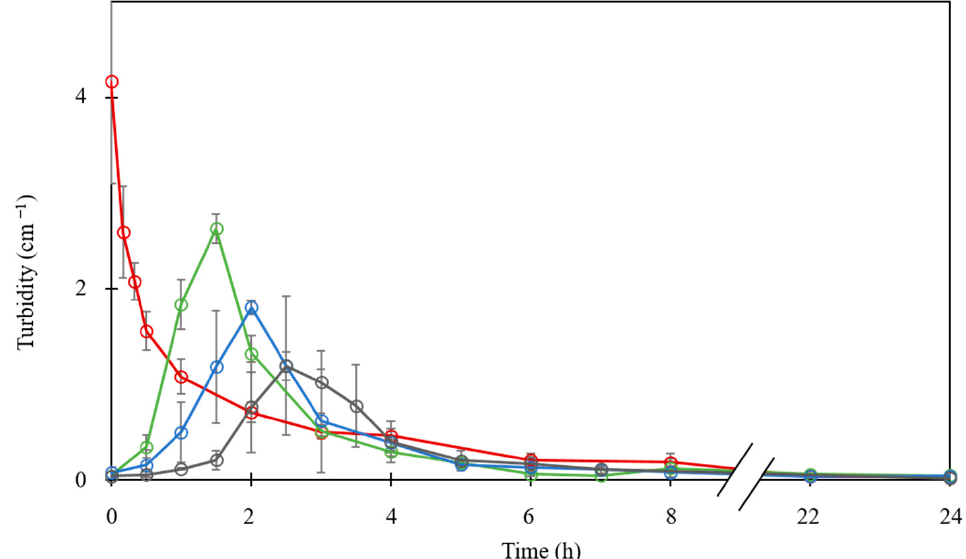
Figure 6. Evolution of turbidity inside the dialysis tube during 24 h desalting experiment of lactoferrin– β -lactoglobulin mixed at total protein concentration of 0.55 mM in 10 mM MES buffer, pH 5.5 at various initial salt concentrations. No added salt ( red ); with added NaCl at concentrations of 100 mM ( green ), 200 mM ( blue ) and 400 mM ( black ).